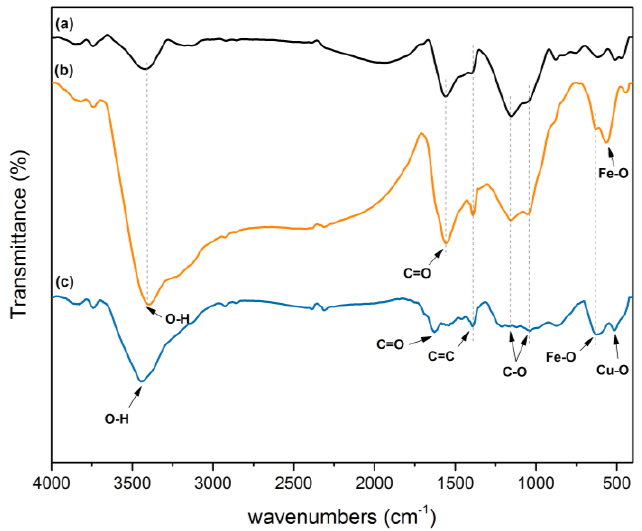
Figure 4. FT-IR spectra of PAC ( a ), Fe 3 O 4 -PAC ( b ), and Cu-Fe 3 O 4 -PAC ( c ).